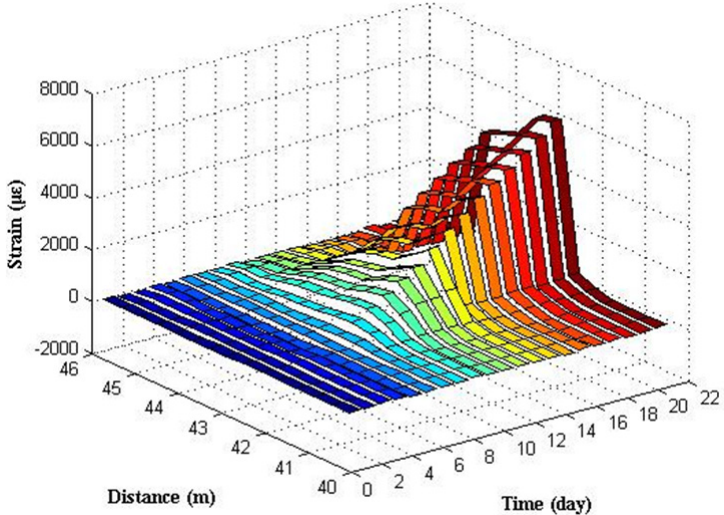
Figure 18. Corrosion expansion strain results of S.3 (II) in experiment two.